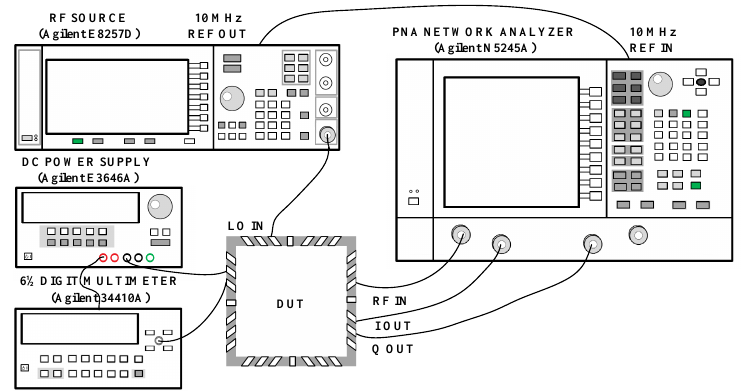
Figure 9. ULP receiver system testing